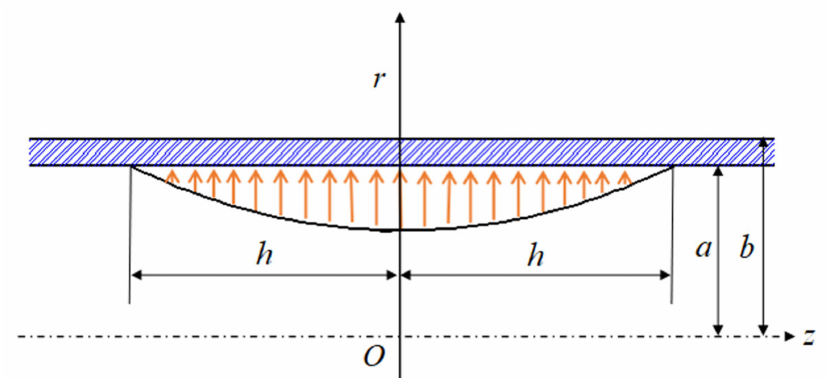
Figure 2. The mechanical model of a metal cylindrical shell under the first pulse. a is the internal radius of the metal cylindrical shell, b is the external radius of the metal cylindrical shell, h is the axial displacement of the explosive load from the maximum value to zero, r is radial displacement of the metal cylindrical